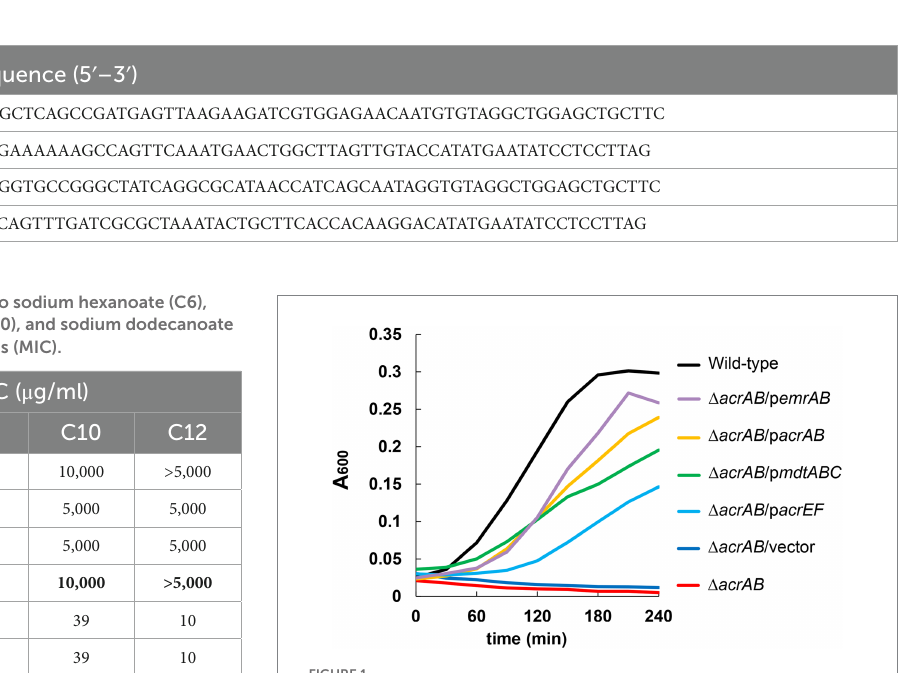
FIGURE 1 Effects of multidrug efflux pumps on the growth of Escherichia coli in the presence of 1,000 μ g/ml of sodium dodecanoate (C12). The growth of the acrAB mutants with plasmids carrying multidrug efflux pump genes. One of the three experiments that have the similar results is